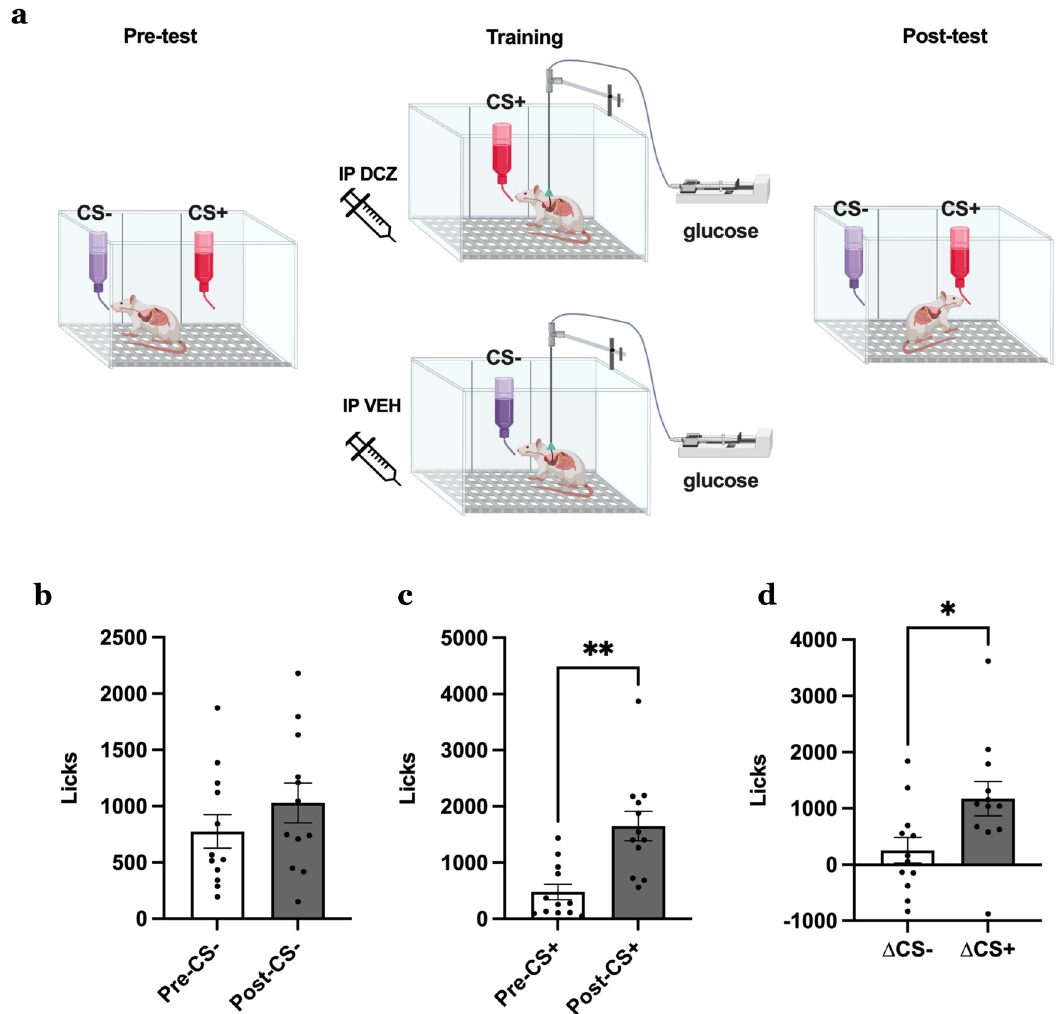
Fig.6|ActivationofMCHneuronsenhancespreferenceforanoncaloric fl avor paired with intragastric (IG) glucose. a Schematic diagram depicting the para- digm for chemogenetic activation of MCH neurons during fl avor preference con- ditioning paired with IG glucose in rats ( n =12). b – d Effects of chemogenetic activation of MCH neurons paired with IG glucose (data analyzed using Student ’ s